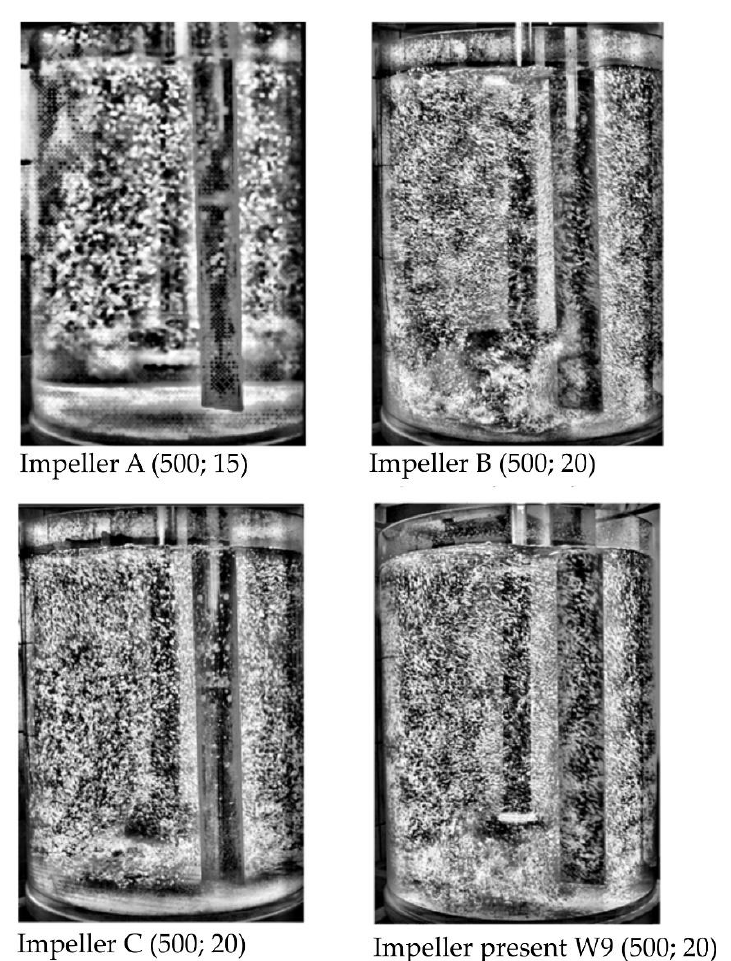
Figure 8. Results of the visualization research for four different types of impeller; in brackets, the impeller speed in rpm and the flow rate of gas in dm 3 · min − 1